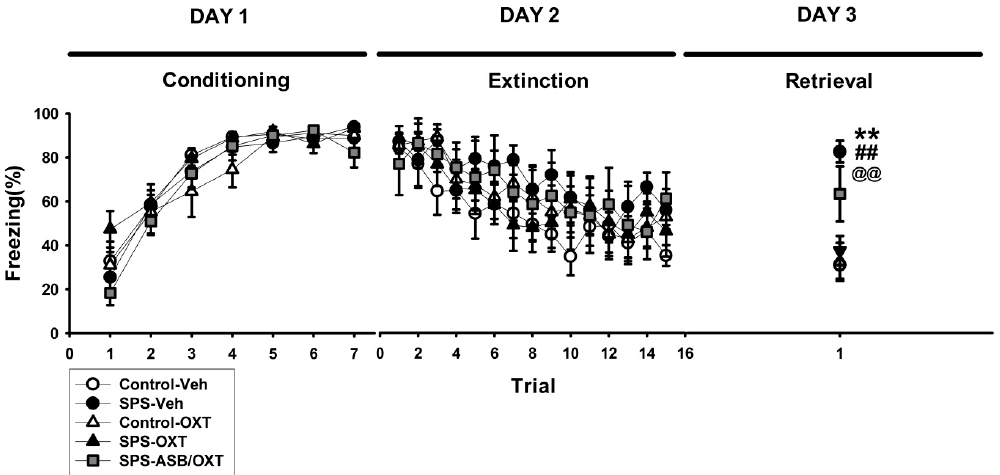
Figure 1. Cue-dependent fear conditioning–extinction test (CDFC test). Oxytocin (OXT) reversed SPS-attenuated fear extinction retrieval (more freezing level in the DAY 3 retrieval stage) and the OXT-related reversal phenomena seemed to be blocked by atosiban (ASB). n = 8 for Control-Veh, SPS-Veh, Control-OXT, and SPS-OXT; n = 6 for SPS-ASB/OXT. Bars represent mean ± SEM. ** p < 0.01, control-Veh vs. SPS-Veh; ## p < 0.01, SPS-Veh vs. control-OXT; @@ p < 0.01, SPS-Veh vs. SPS-OXT. SPS: single prolonged stress; Veh: vehicle, OXT: oxytocin, ASB: atosiban.